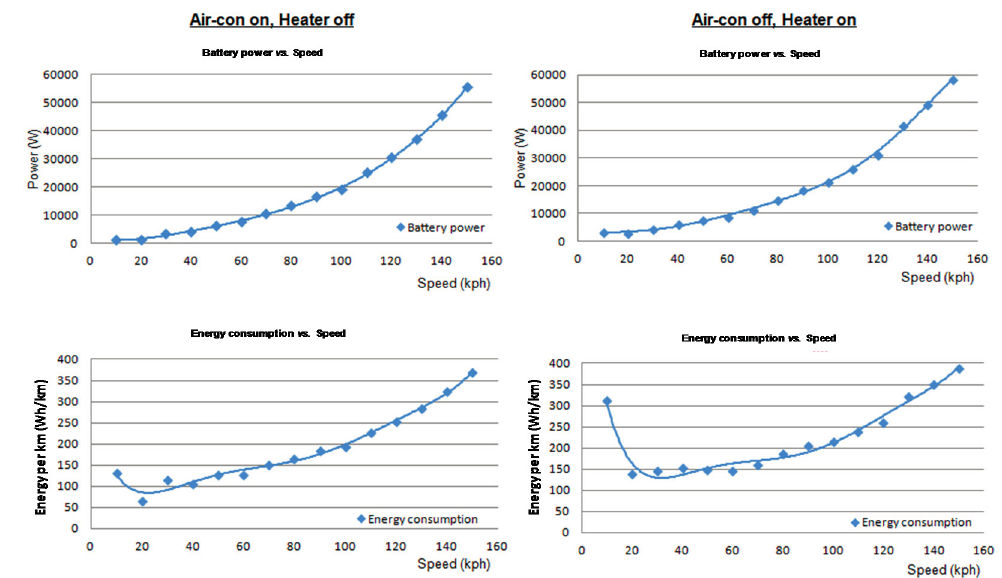
Figure 3. Energy consumption according to vehicle